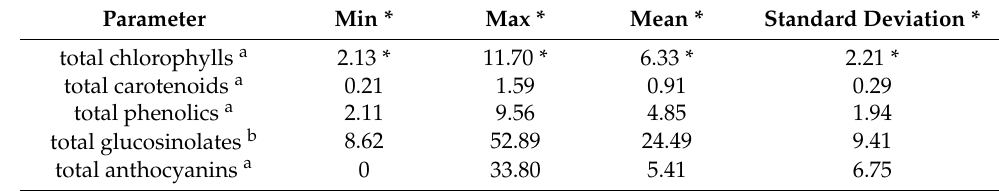
Table 3. Minimum, maximum, and mean content for the five functional components in B. juncea .